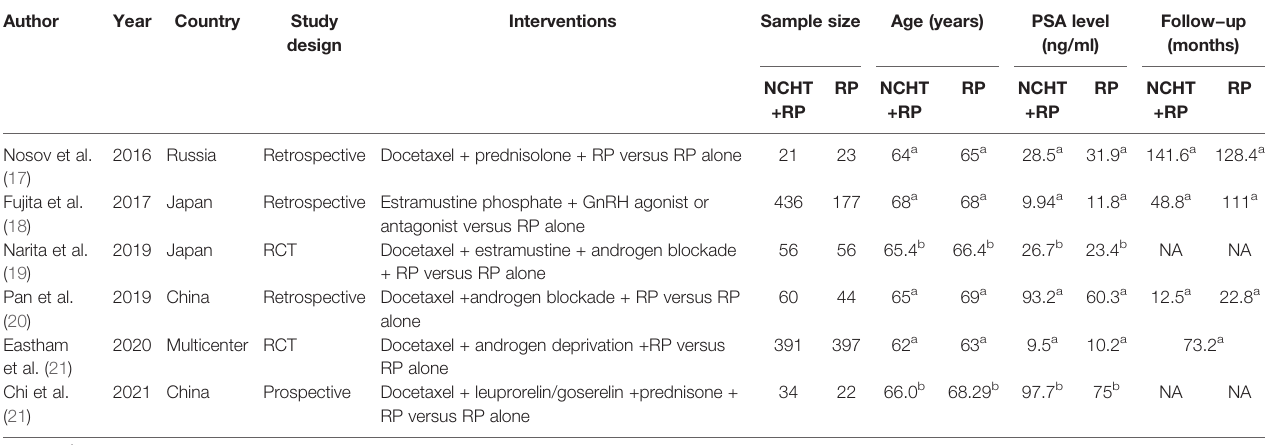
TABLE 1 | Baseline characteristics and interventions included in the meta-analysis.